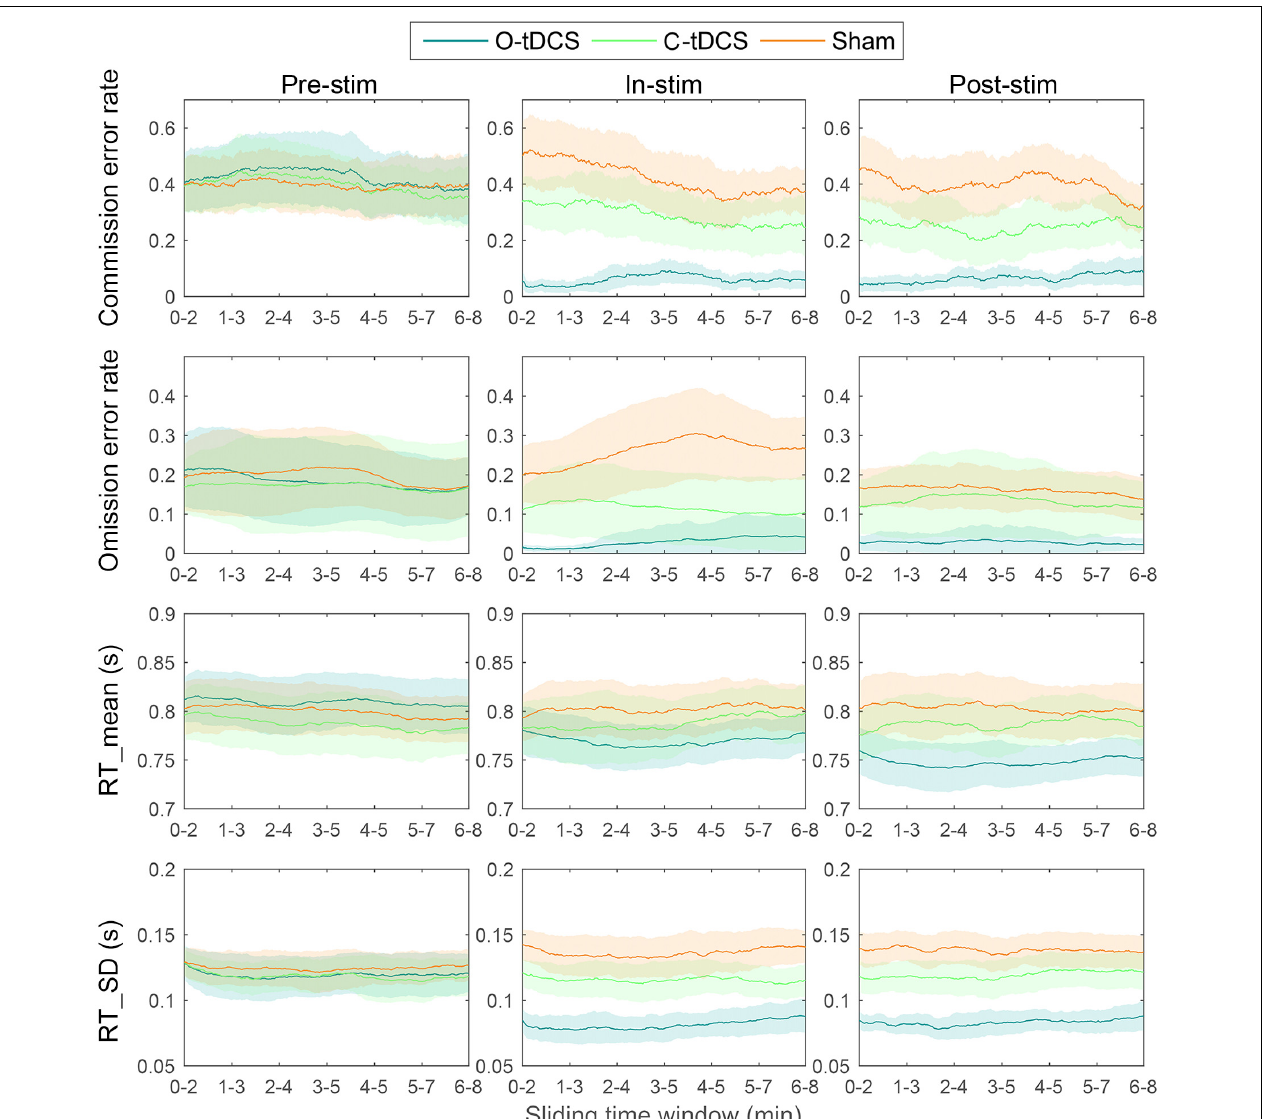
FIGURE 3 | The vigilance decrement effect. There was no vigilance decrement as well as stimulation and test effects indicated by the slope. Lines show the mean values. Shadows show the 95% confidence intervals.